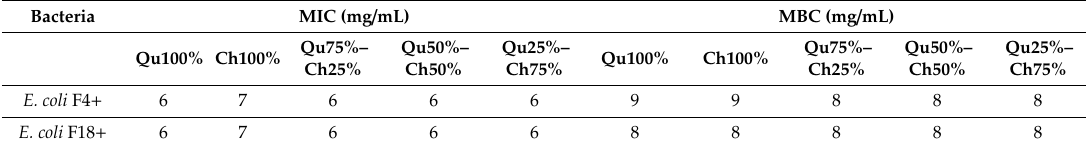
Table 2. The minimal inhibitory concentration (MIC) and minimal bactericidal concentration (MBC) of Qu and chestnut tannins on E. coli F4+ and F18+.